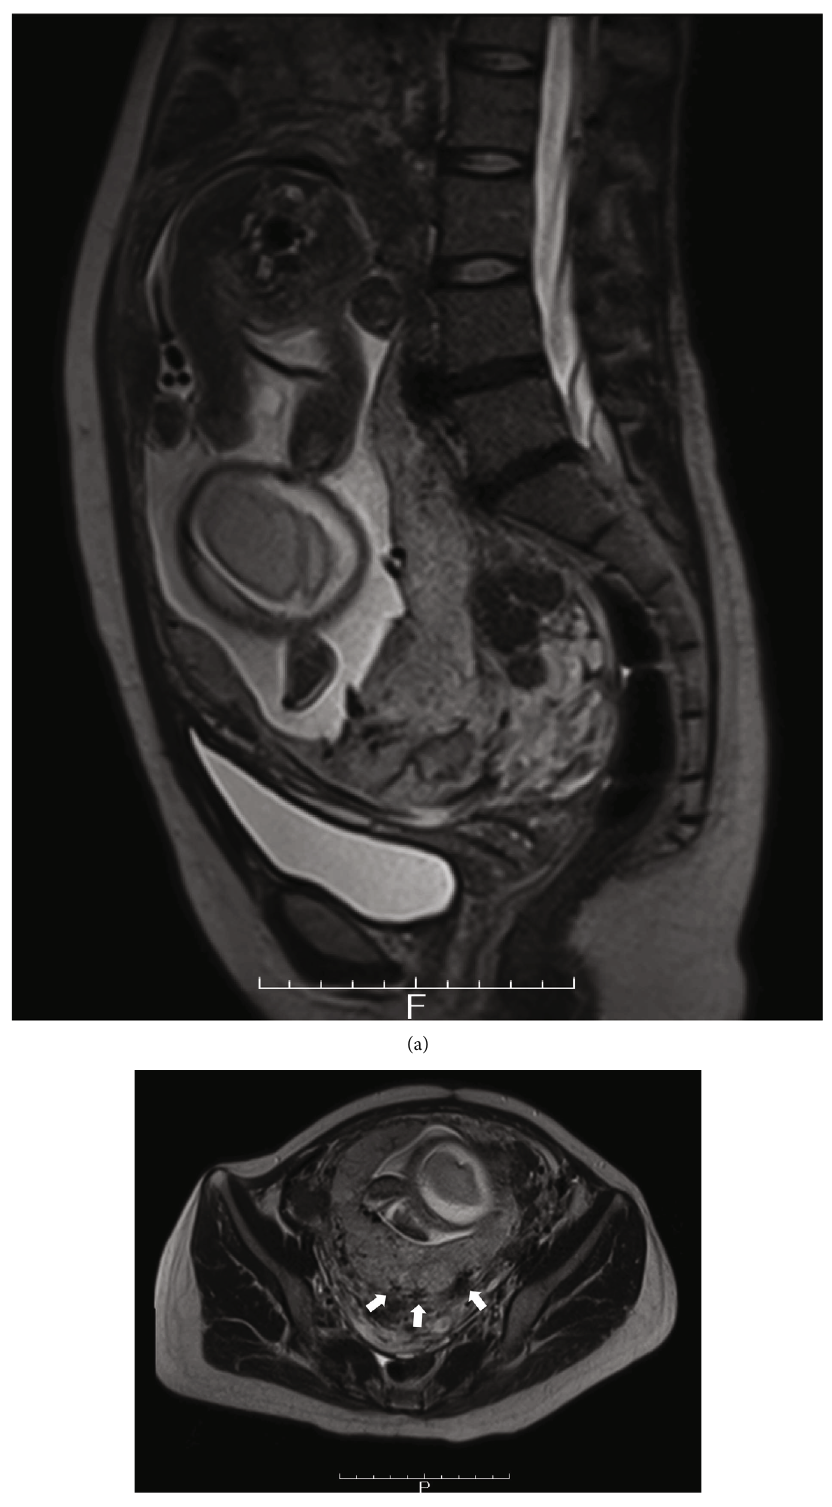
Figure 3: MRI fi ndings of placenta previa. (a) Sagittal and (b) axial image. Arrows represent placental recess (a wedge-shaped contraction of the placental surface and uterine outer rim accompanying a T2 dark